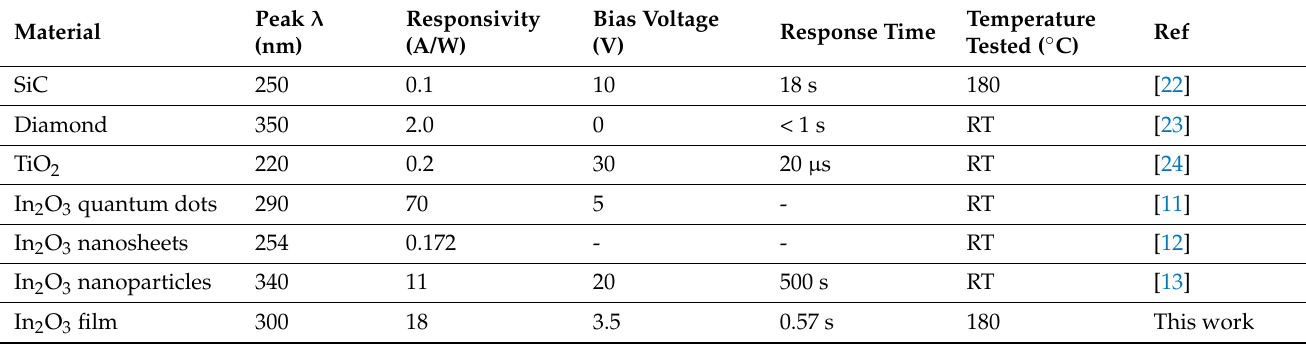
Table 1. Comparison of the key device performance of the reported UV